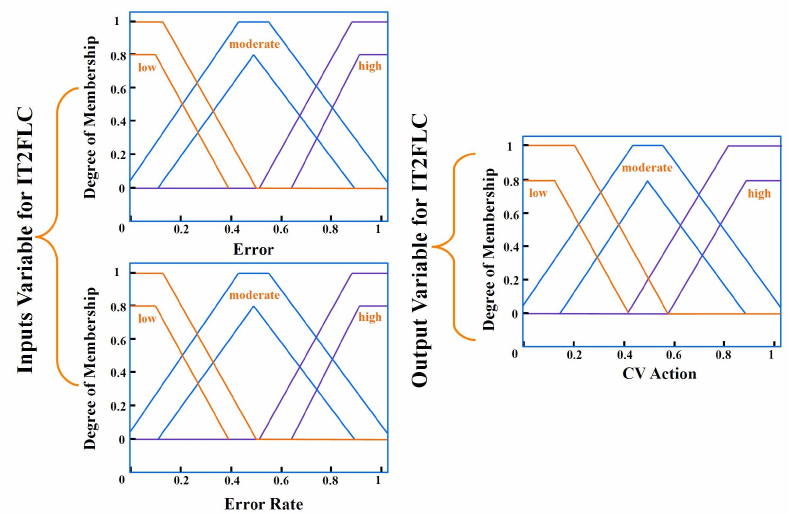
Figure 5. Fuzzy inference system using IT2FIS for TTCFNLC system.